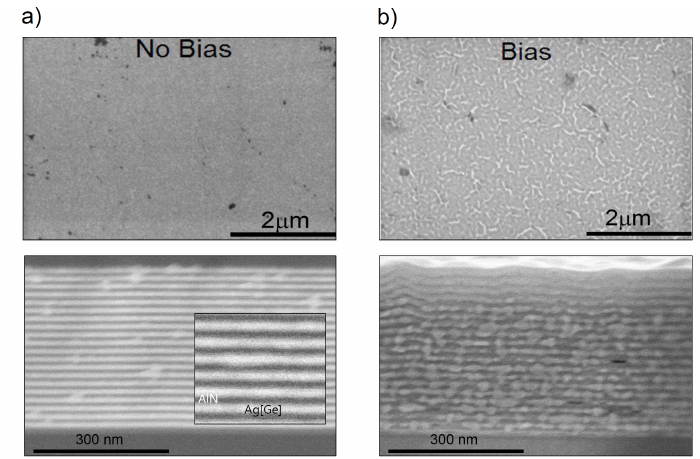
Figure 2. SEM micrographs in planar ( top ) and cross-sectional ( bottom ) view of the Ag[Ge]/AlN NMLs produced ( a ) without substrate bias and ( b ) with substrate bias.